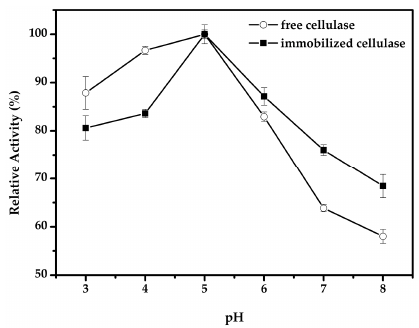
Figure 6. Effect of pH on the activity of immobilized cellulase.